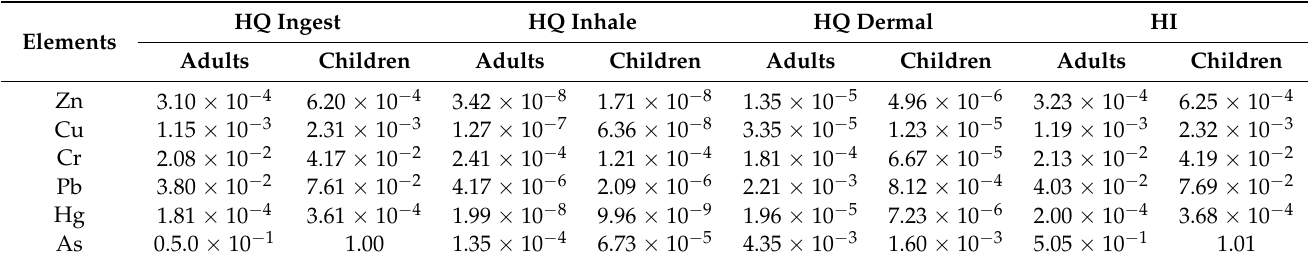
Table 6. The non-carcinogenic risk index values of the heavy metals in soil.